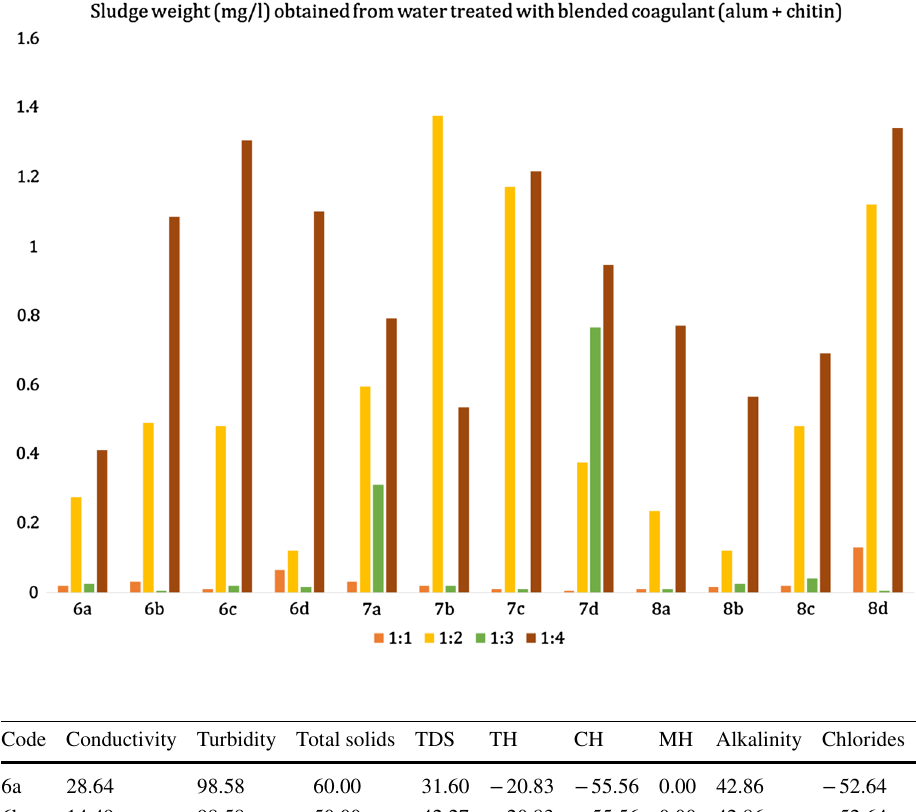
Table 6 Percentage reduction in various physicochemical parameters of surface water after treatment with blended coagulant (alum + sago—1:1 ratio)